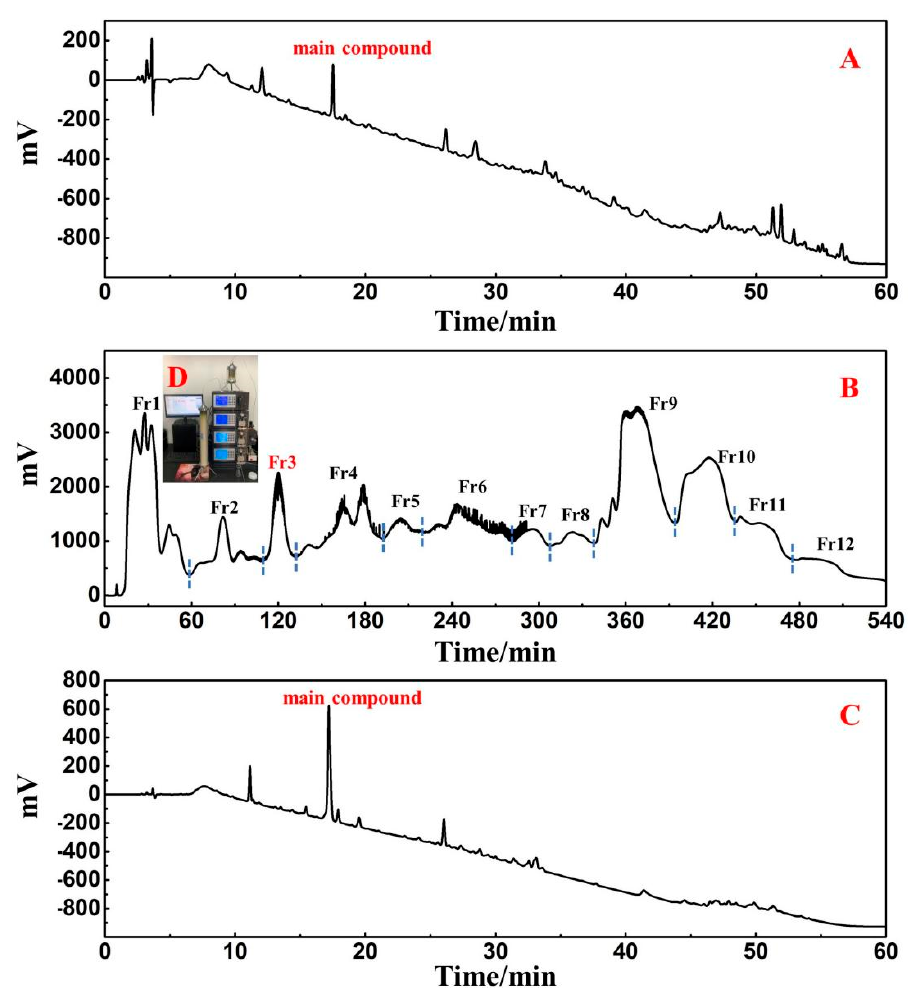
Figure 1. ( A ) The analytical chromatogram of crude Medicago sativa sample on the ReproSil − Pur C18 AQ analytical column. ( B ) The crude extract chromatogram of medium-pressure liquid chro- matography pretreatment with MCI GEL ® CHP20P as the stationary phase. ( C ) The analytical chromatogram of fraction Fr3 on the ReproSil-Pur C18 AQ analytical column. ( D ) The actual MCI GEL ® CHP20P medium-pressure liquid chromatography system.